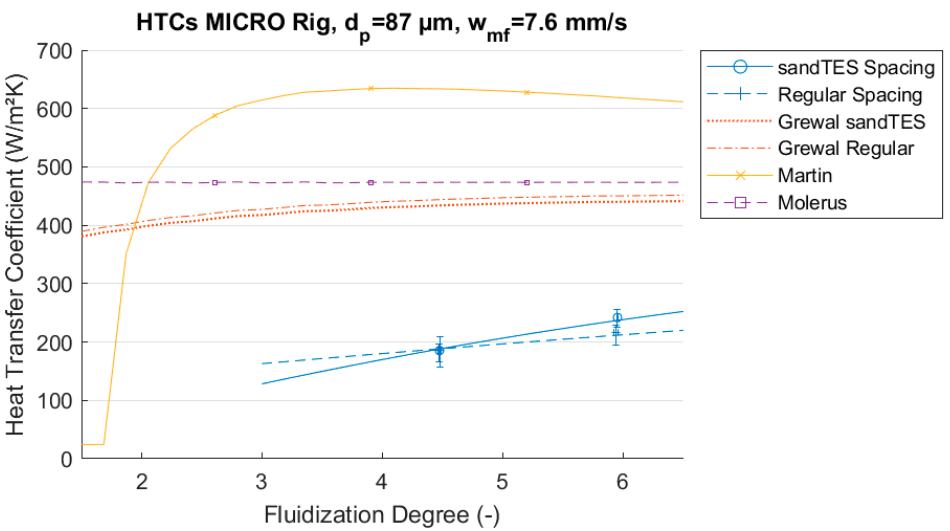
Figure 20. Comparison of MICRO results with 87 µm particles.